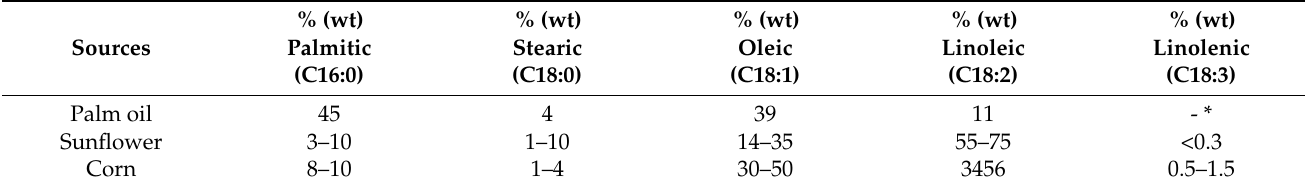
Table 4. Measured fuel blend properties of all tested fuel [60,68–73].